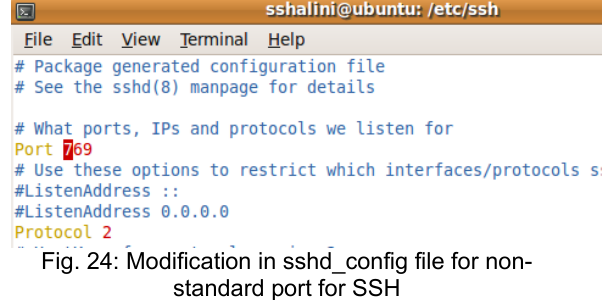
Fig. 24: Modification in sshd_config file for non- standard port for